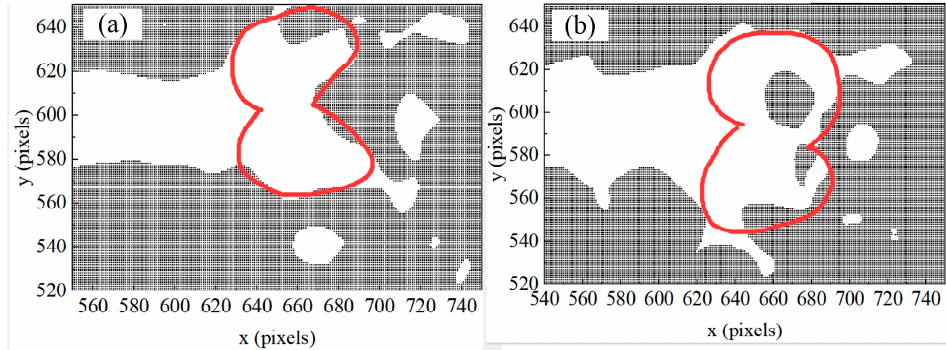
Figure 6. Contours of the plastic zone at the crack tip of specimen B1 and W1: ( a ) B1-a = 25.02 mm; ( b ) W1-a = 24.48 mm. Method 2 : Plastic zone profile retraction r p method to determine the tip